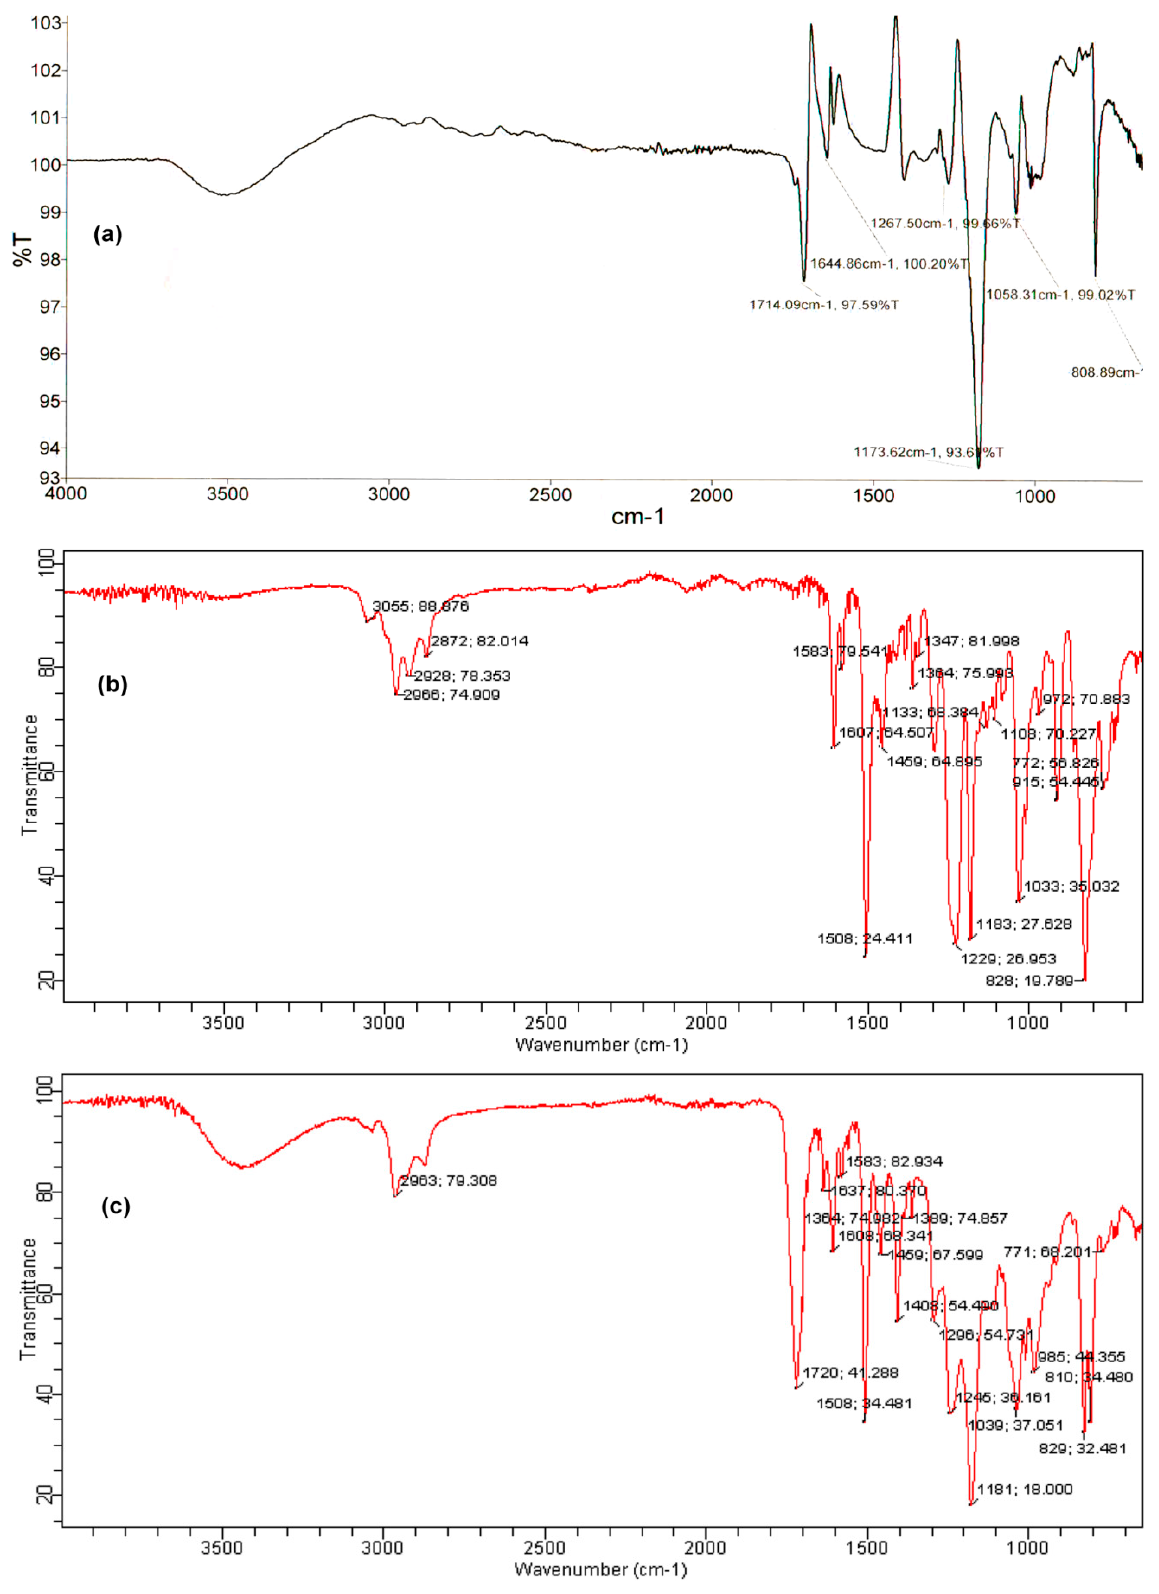
Figure 1. The FT-IR spectrum of ( a ) acrylic acid, ( b ) DGEBA epoxy resin, and ( c ) synthesized vinyl ester resin.